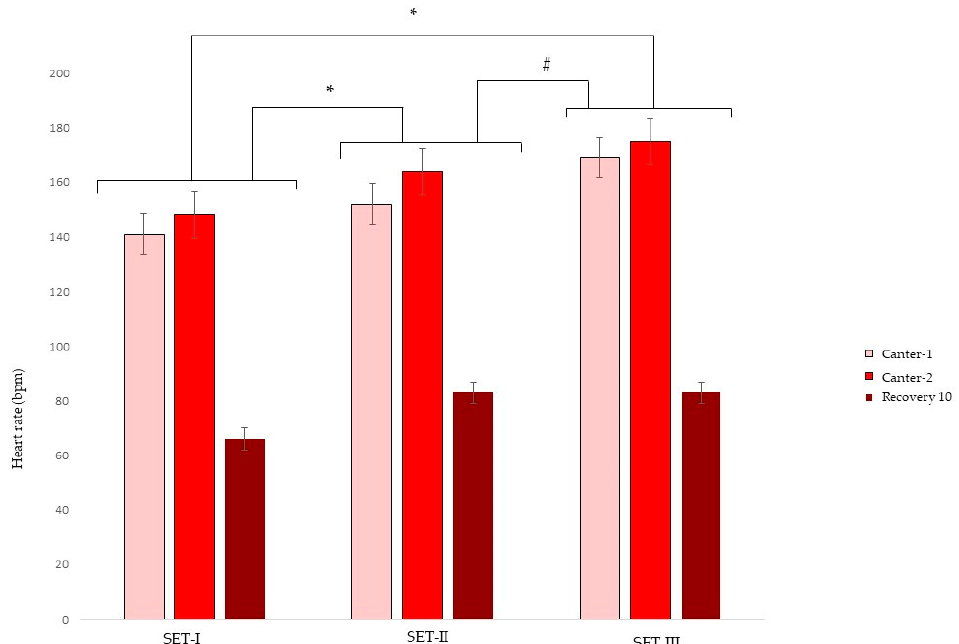
Figure 2. Mean ± SD heart rate (bpm) during three consecutive standardized exercise tests (SET-I, -II and -III) in young Friesian stallions with 5 (SET-I -SET-II) and 4 (SET-II–SET-III) weeks in between. * Indicating an overall statistical difference from SET-I; # indicating an overall statistical difference from SET-II.